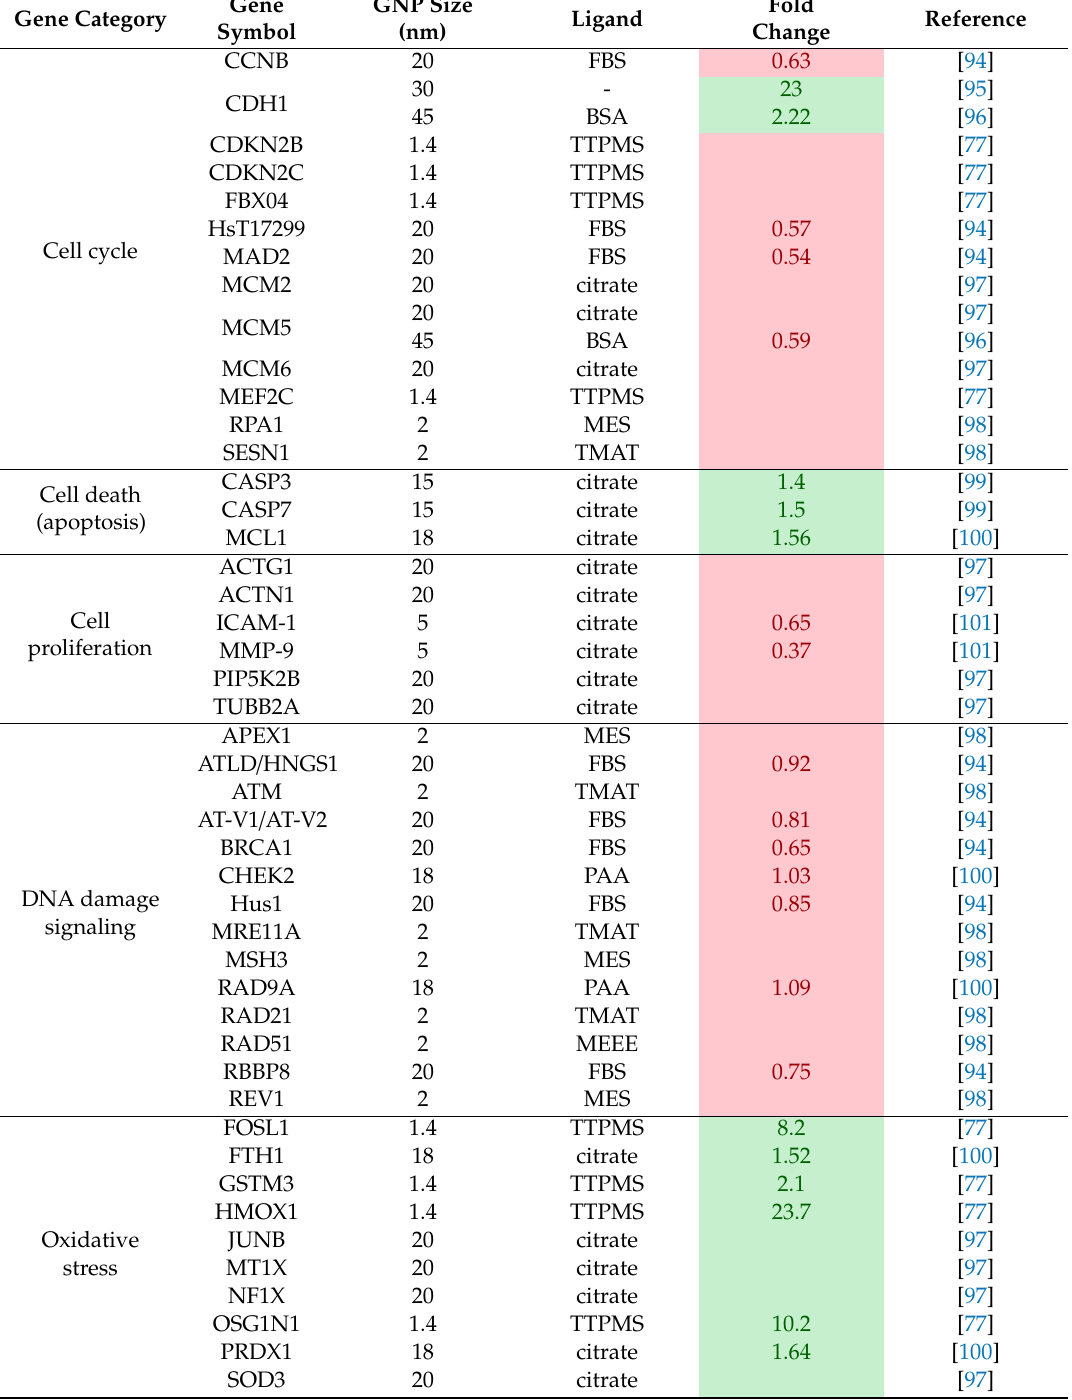
Table 2. Non-exhaustive list of gene expression changes in cells incubated with GNPs. Upregulated and downregulated genes are highlighted in green and red, respectively. When data are available in the publications, fold change is reported in the